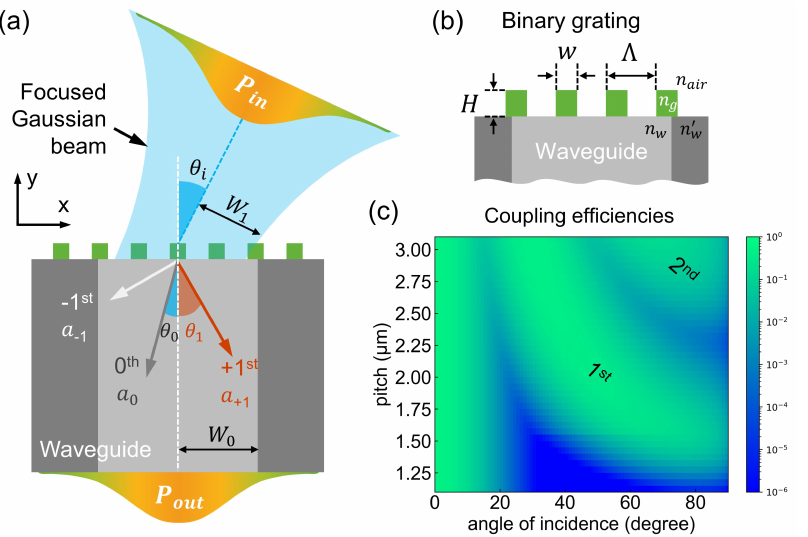
Figure 1. Grating-enhanced waveguides for wide-angle light collections. ( a ) Schematic showing a microstructure-modified waveguide excited by a focused Gaussian beam. ( b ) A close look at a binary grating. ( c ) The calculated coupling efficiencies based on a 2D analytical